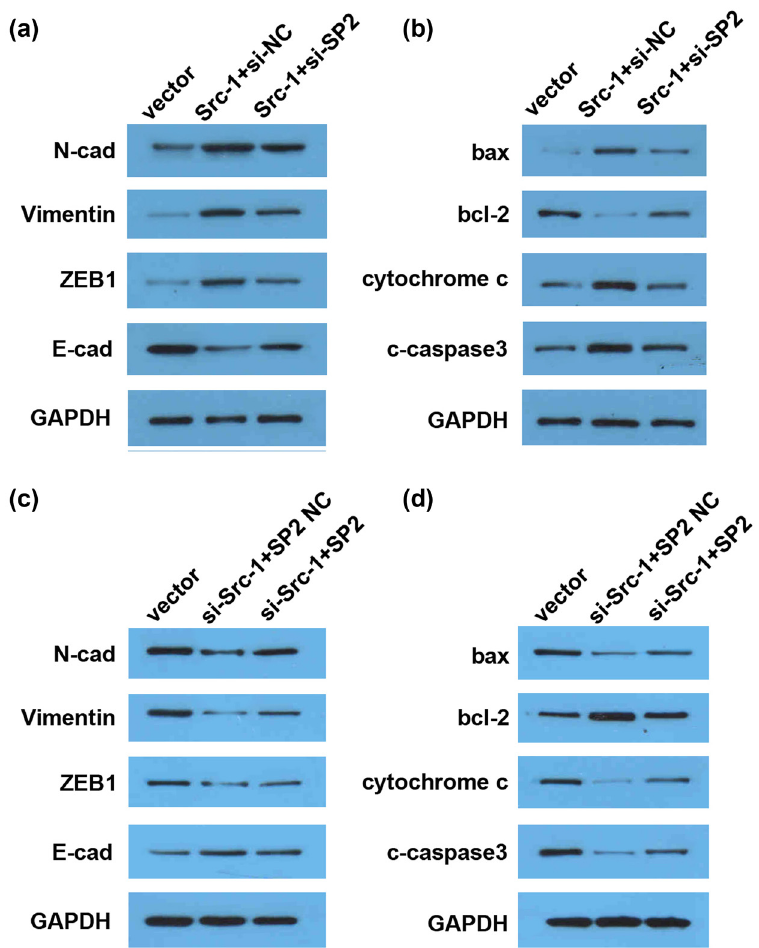
Figure 4: Src - 1 regulates the expression of EMT - and proliferation - related genes in SP2 - dependent manner. ( a – d ) The protein level deter - mined by Western blot. Downregulation of SP2 alleviated Src - 1 - induced decrease of E - cad, bax, cytochrome c, and cleaved caspase3, and increase of N - cad, Vimentin, ZEB1, and bcl - 2. Overexpression of SP2 abated the e ff ects of Src - 1 knockdown on the expression of E - cad, bax, cytochrome c, and cleaved caspase3, and increase of N - cad, Vimentin, ZEB1, and bcl -